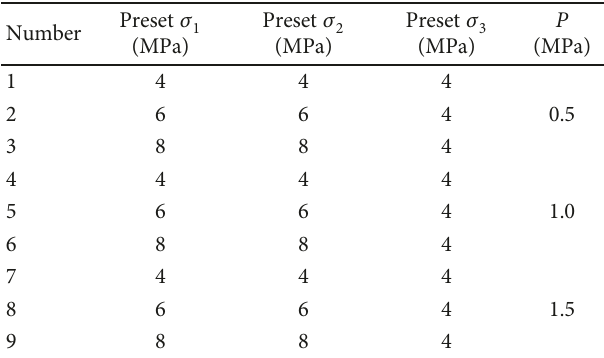
Table 1: Loading parameters.